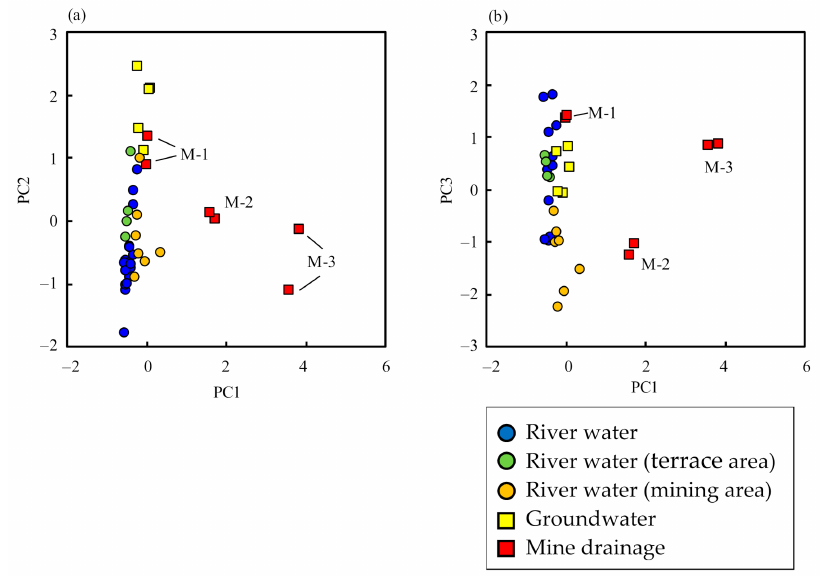
Figure 6. Principal component scores of ( a ) PC1 vs. PC2 and ( b ) PC1 vs. PC3.